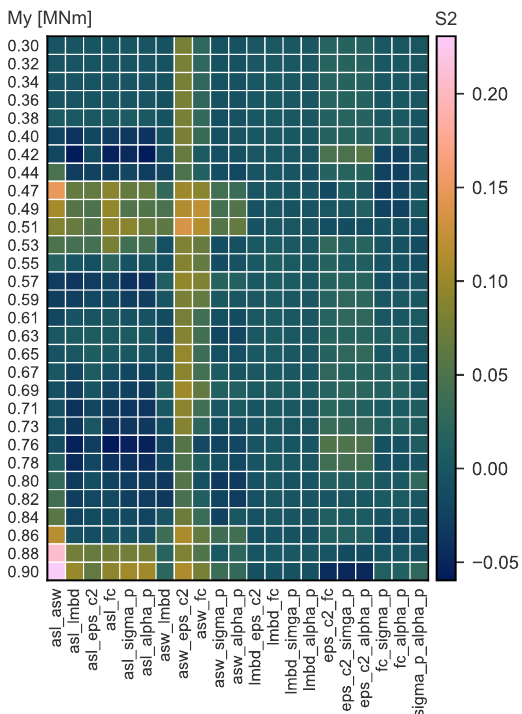
Figure 5. Individual parameter importance S1 and total prioritisation ST affecting k c